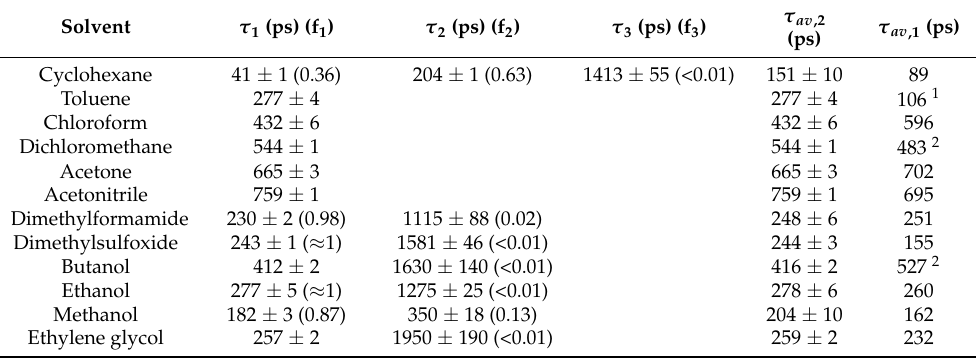
Table 4. Decay times, τ i , and pertaining relative amplitudes resolved in the fluorescence decay distri- butions measured for 2 in the different solvents of Table 1. In the last two columns the corresponding average S 1 state lifetimes, τ av , 2 , calculated according to Equation (1), are compared to those of 1 , τ av , 1 , reproduced from [38] for the sake of straightforward